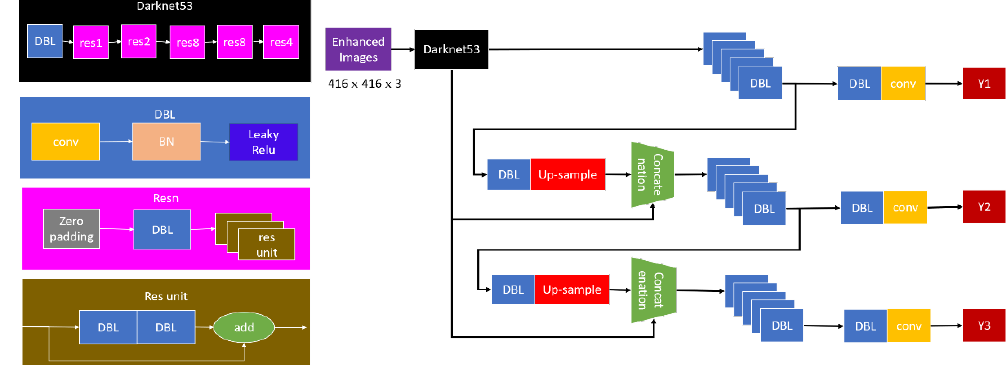
Figure 7. The PDM-Net architecture .